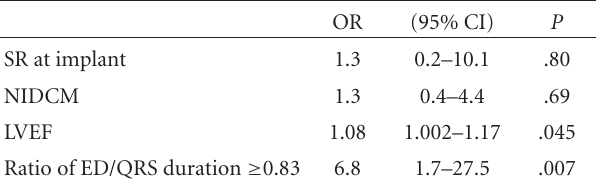
Table 3: Multivariate predictors of response to